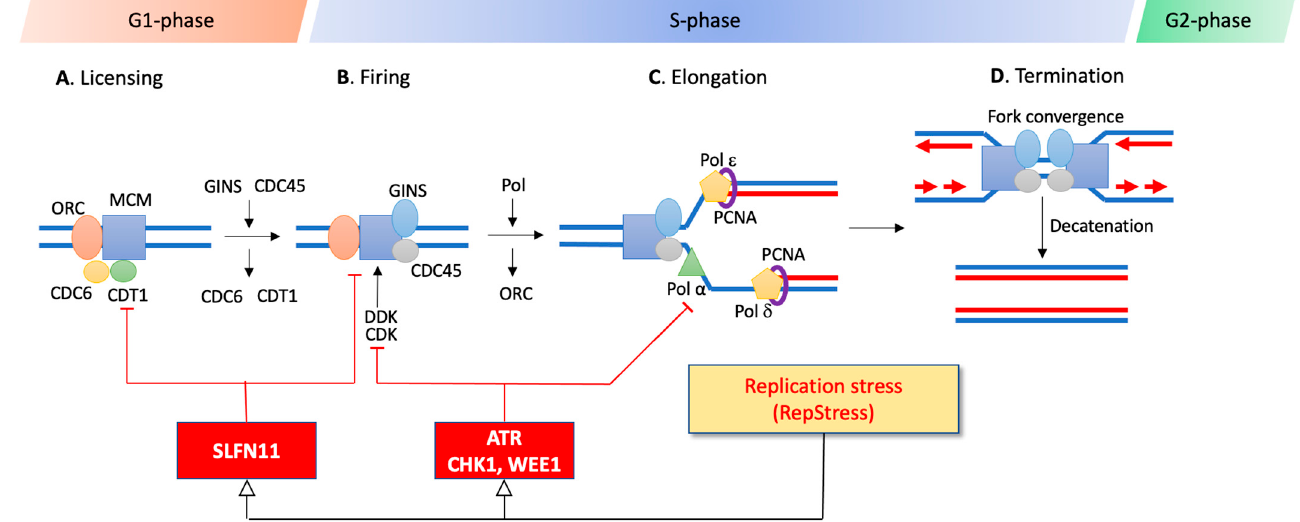
Figure 3. Schematic representation of the DNA replication steps in the context of the cell cycle and of the ATR and SLFN11 replication checkpoints. DNA replication is initiated by recognition of replication origins scattered along the genome. A, In G1, active origins of replication are licensed by ORC, CDC6, CDT1, and MCM2 ‐ 7, forming the pre ‐ replication complex (pre ‐ RC). B, At the G1 ‐ S transition, the pre ‐ RC complex is fired by activation of kinases (DDK and CDK) and loading GINS and CDC45, thereby unwinding the DNA duplex and initiating the replication by DNA polymerases. C, Active replication forks are elongated by the replication machinery including helicases, PCNA and DNA polymerases throughout S ‐ phase. D, The replication process is terminated when the bidirectional replication forks merge. The RepStress is monitored and modulated by replication checkpoints, ATR and SLFN11, which are both recruited to RPA filaments. While ATR produces a transient cell cycle arrest allowing DNA repair, SLFN11 produces an irreversible replication arrest.